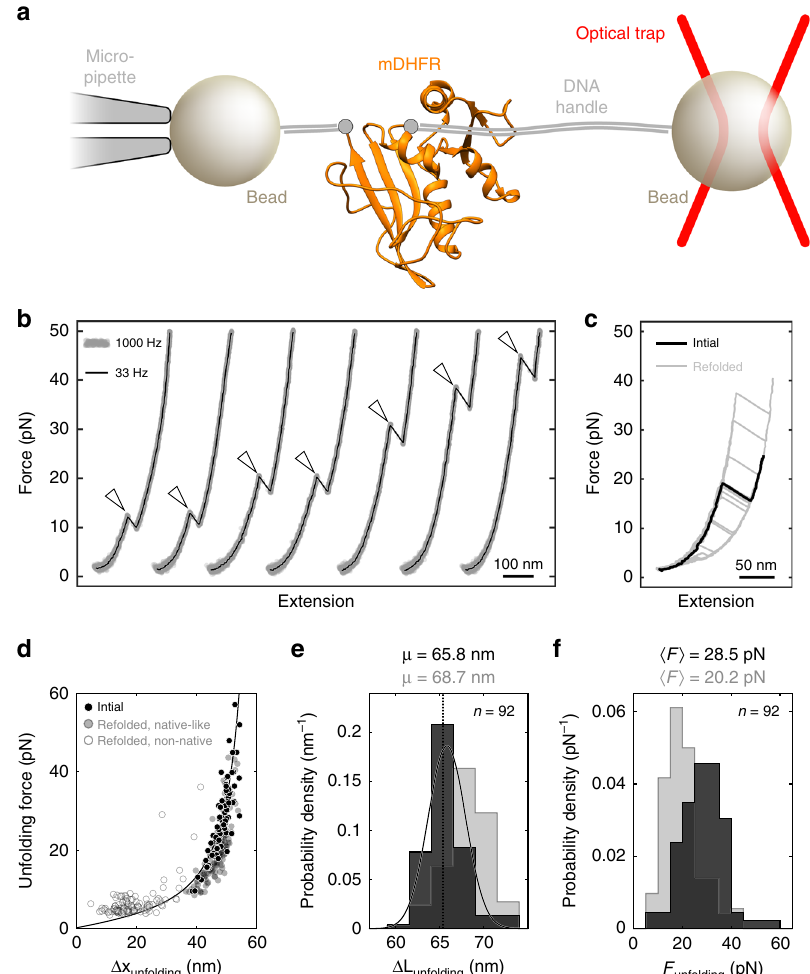
Fig. 2 apo-mDHFR is mechanically stable and structurally heterogeneous. a Cartoon schematic of optical tweezers experiment (not to scale). mDHFR is tethered by its termini between two beads for mechanical manipulation with an optical tweezers. b Example force-extension curves showing initial unfolding events (arrowheads) for seven apo-mDHFR molecules, plotted with an offset along the horizontal axis for clarity, and sorted by unfolding force in ascending order. c Force-extension curves for the initial (black line) and subsequent (gray lines) unfolding of a single apo-mDHFR molecule. Some of the curves recorded after refolding resemble the initial one, others occur at low force with shorter extension changes. d Scatter plot of initial (black circles) and subsequent (open and fi lled gray circles) unfolding events for 92 apo-mDHFR molecules. Each dot represents an unfolding event, characterized by the unfolding force ( y -axis) and the extension change upon unfolding ( Δ x unfolding , x -axis). Subsequent unfolding events are colored depending on whether they exhibit native-like ( fi lled gray circles) or non-native (open gray circles) characteristics. Black line: worm-like chain model calculated for native mDHFR unfolding. e , f Histograms showing the distributions of contour length changes ( e ) and unfolding forces ( f ) for initial (dark gray) and native-like (light gray) unfolding transitions. A fi t of the contour length changes from initial events to a normal distribution (solid line) yields a mean ( µ ) close to the expected value (dotted line) for mDHFR unfolding. The unfolding forces from initial events exhibit a distribution with a tail at high force that is uncharacteristic for unfolding from a single state. The respective distributions for native-like transitions overlap with those for initial events, but are statistically distinct, indicating inef fi cient refolding to the initial structure. Average unfolding forces ( 〈 F unf 〉 ) are indicated on top of panel ( f ). Source data are provided as a Source Data fi to the initial unfolding (Fig. 2d, gray dots) exhibited contour length and unfolding force distributions that overlapped with, but were distinct from, the initial events (Fig. 2e, f). We conclude that mDHFR does not refold ef fi ciently under our experimental conditions and therefore focused our analysis on the initial unfolding events.